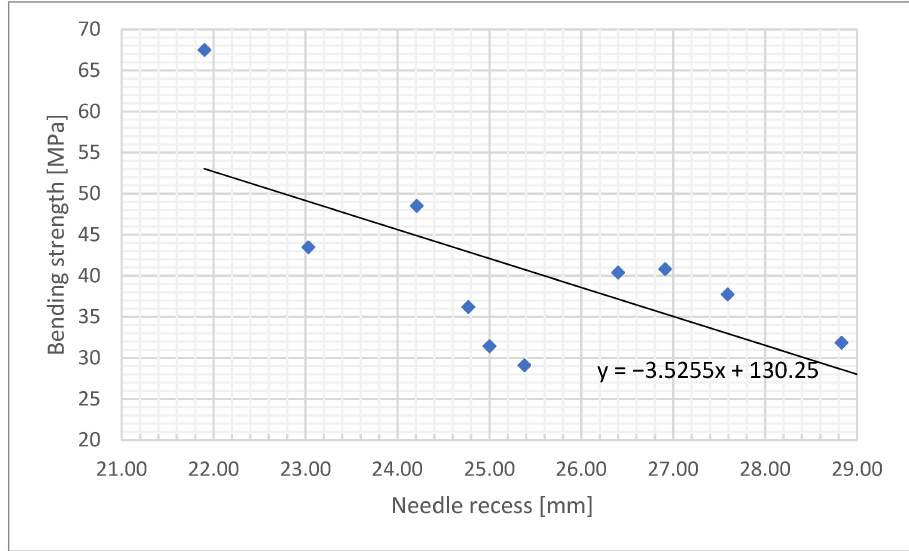
Figure 14. Correlation between the needle recess from the side of the element and its bending strength for the pine wood elements.